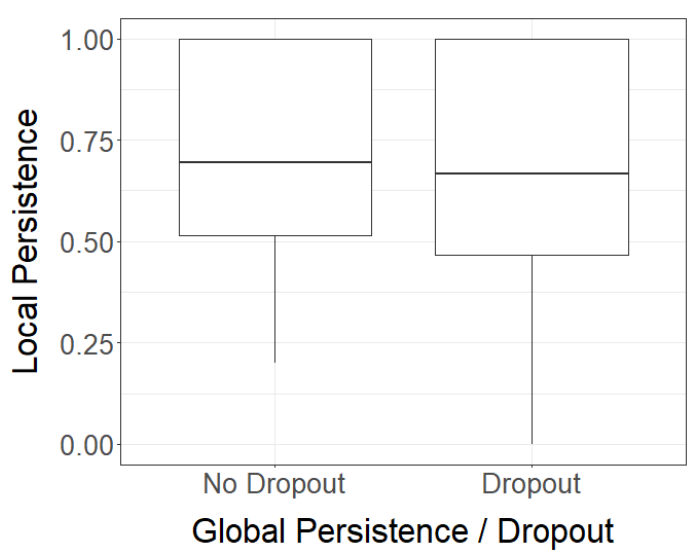
Figure 5. Boxplot with the relationship between local persistence and dropout.